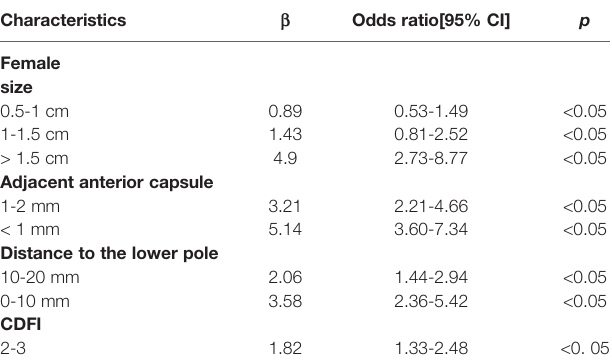
TABLE 4 | Multivariate logistic regression analysis of risk factors for female.